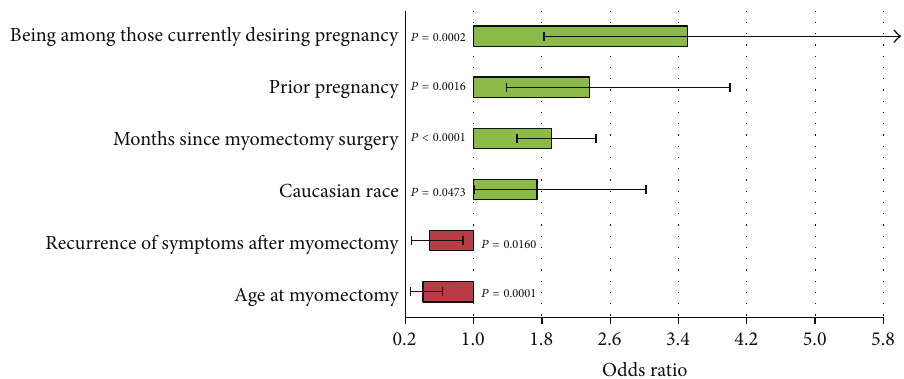
Figure 4: Factors independently associated with achieving pregnancy. Shown are the factors that were statistically significant at 𝑃 < 0.05 in forward stepwise logistic